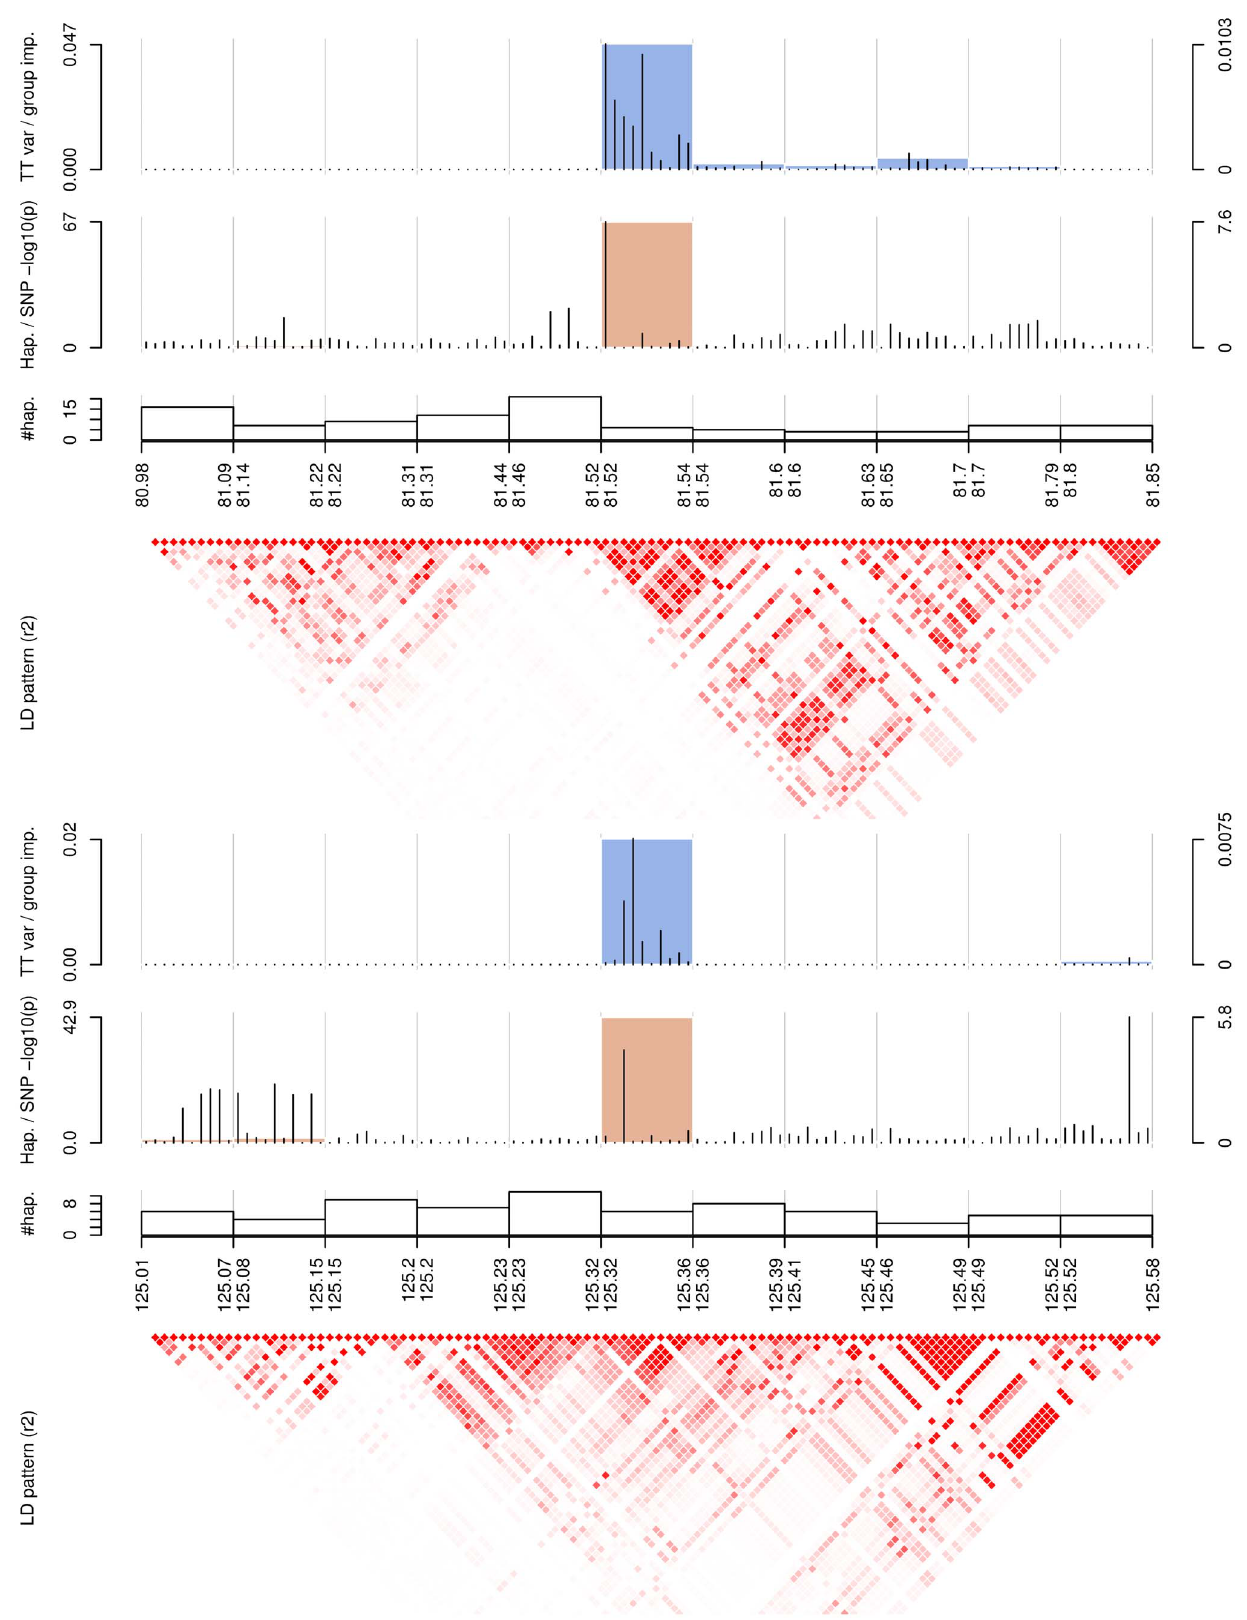
Figure 2. Group and variable importances for the two novel candidate regions for Crohn’s disease. Regions 2p12 (top) and 7q31 (bottom), as found by T-Trees on CD qc . First row: SNP and block importances. Second row: univariate (Fisher) p-values and haplotype p-values as